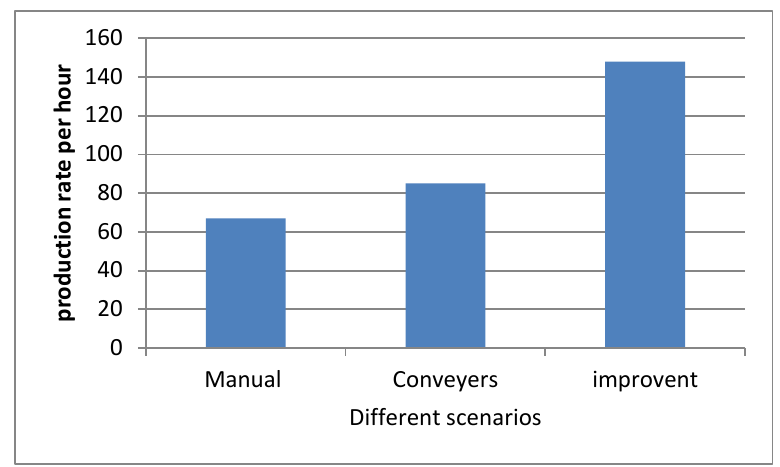
Figure 8: Production rate for the three different